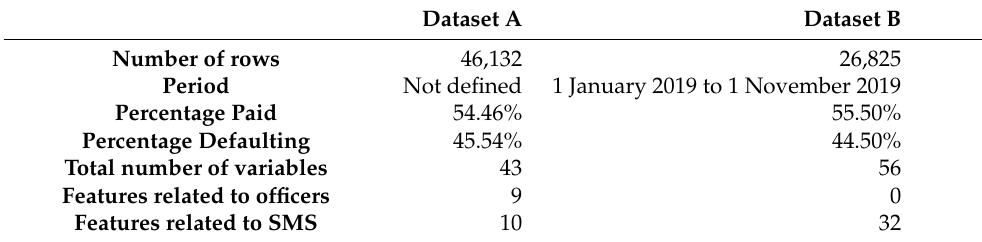
Table 1. Description of an overview of dataset A and B, and its main